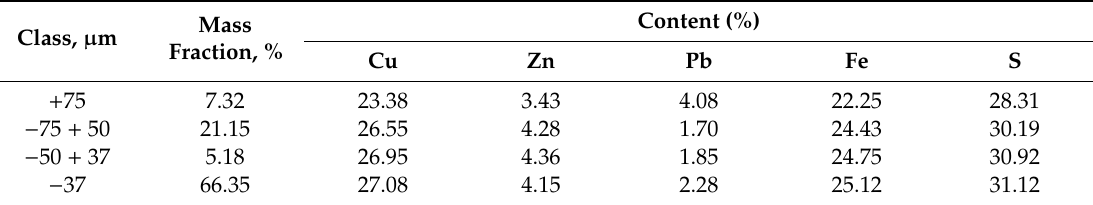
Table 1. Granulometric and chemical composition of the chalcopyrite concentrate samples. Class, µ